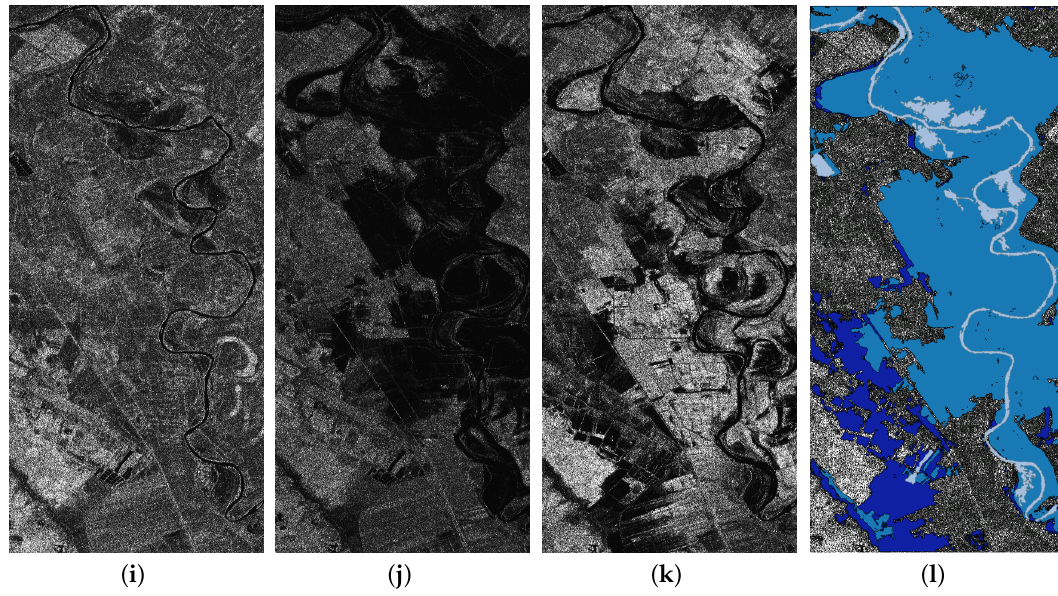
Figure 7. Our approach applied to three different sites (clear blue indicates water bodies, medium blue illustrates flood extent at t 1 and dark blue denotes the difference between the two flood extents extracted at t 1 and t 2 ). ( a ) Pre-disaster image (site 1); ( b ) Post-disaster image t 1 (site 1); ( c ) Post-disaster image t 2 (site 1); ( d ) Obtained result; ( e ) Pre-disaster image (site 2); ( f ) Post-disaster image t 1 (site 2); ( g ) Post-disaster image t 2 (site 2); ( h ) Obtained result; ( i ) Pre-disaster image (site 3); ( j ) Post-disaster image t 1 (site 3); ( k ) Post-disaster image t 2 (site 3); ( l ) Obtained